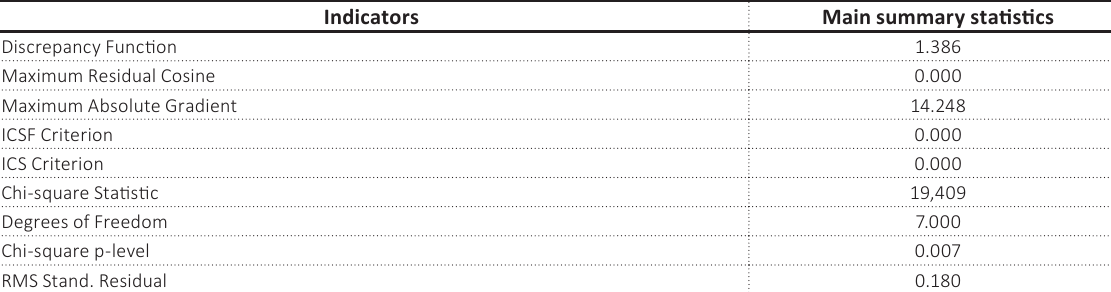
Table 5. Main summary statistics to study the relationship between banking institutions’ nonperforming loans, profitability and financial stability of the Ukrainian banking sector